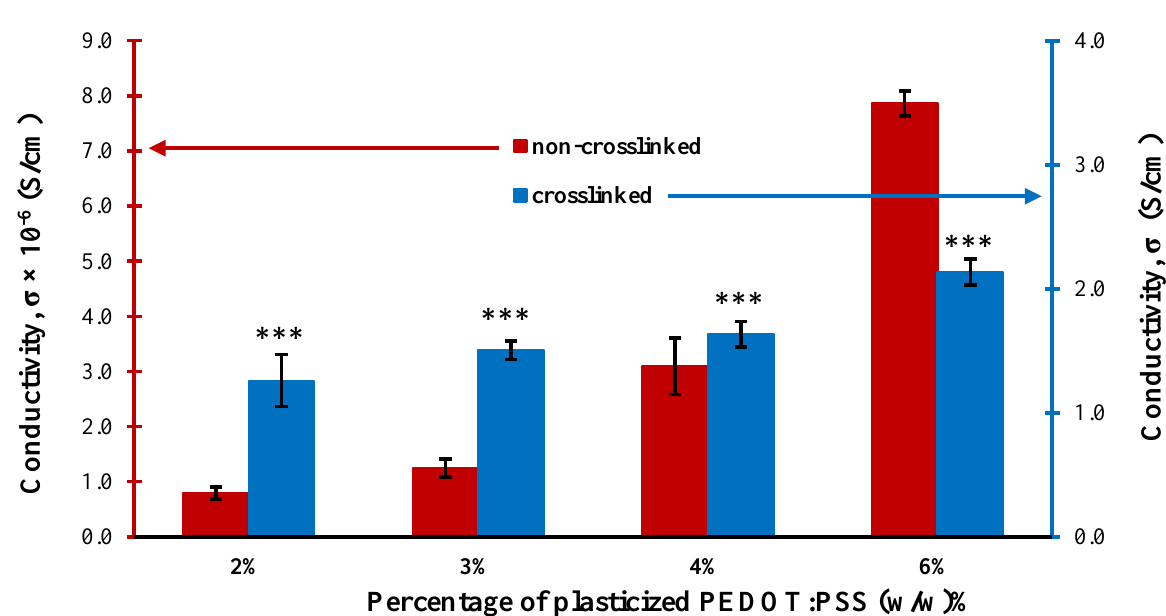
Figure 10. Electrical conductivity of non-crosslinked and crosslinked conductive hydrogel films. Denotes *** p < 0.00001.